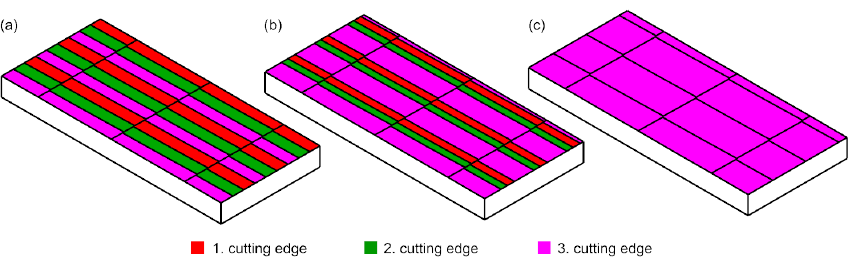
Figure 5. Surface texture model for f t = 0.06 mm, b r = 0.4 mm and the radial runout of the tool ∆ r